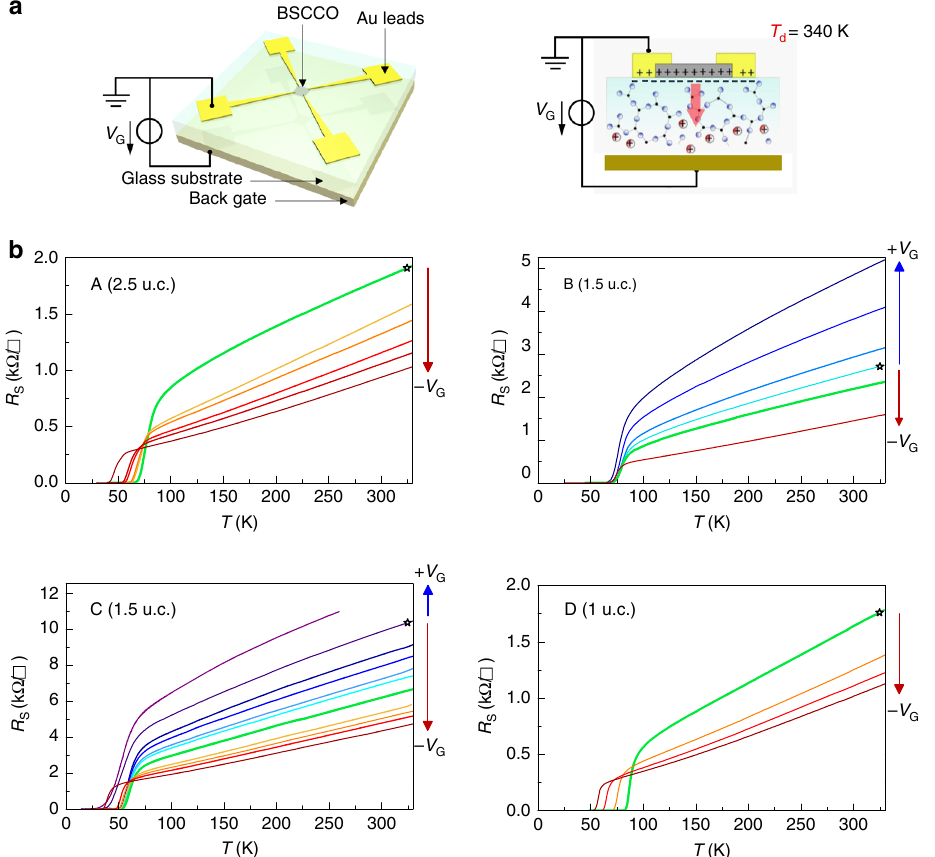
Fig. 1 Overview of space charge doped BSCCO-2212 2D crystals. a Schematic top and side view of devices. b R S ( T ) for the four devices of this study at varying doping levels controlled by the gate voltage V G . Curves corresponding to the initial doping are indicated with stars; the underdoped region corresponds to cyan-blue curves, whereas the overdoped region corresponds to yellow-brown curves; R S curves corresponding to the optimal doping level are plotted in thick green lines. Though samples A and D have not been swept through the optimal doping point, the fact that their initial doping is optimal is con fi rmed by the Hall coef fi cient measured in these samples as shown in Table